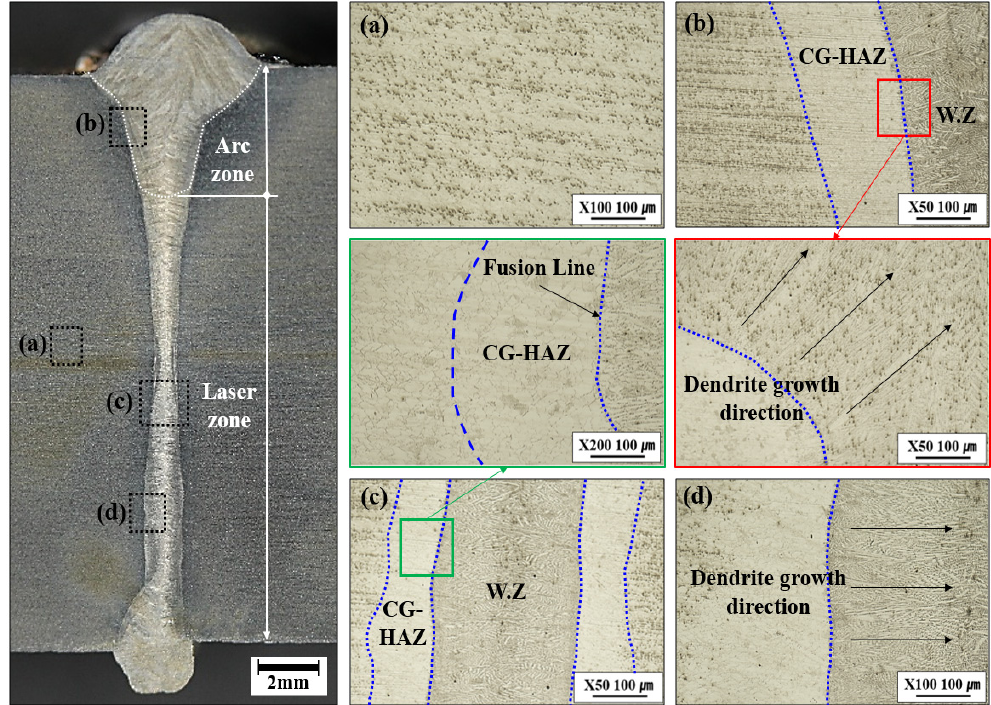
Figure 9. Optical micrograph of the laser-MIG hybrid welded joints. ( a ) Base metal, ( b ) WZ + CG-HAZ of the arc zone, ( c ) WZ + CG-HAZ of the laser zone, and ( d ) dendritic growth direction of the laser zone.